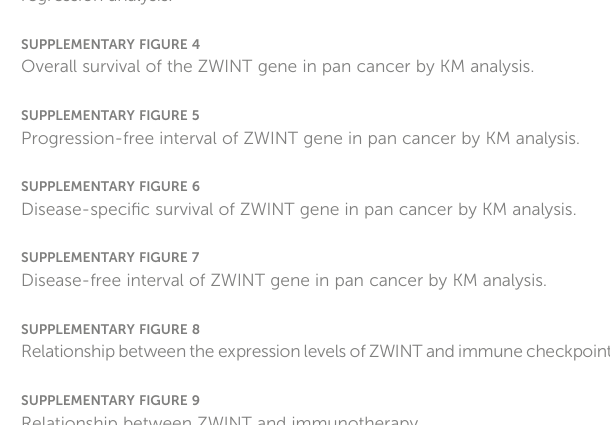
SUPPLEMENTARY FIGURE 10 Association of ZWINT expression with clinical characteristics of NSCLC patients.